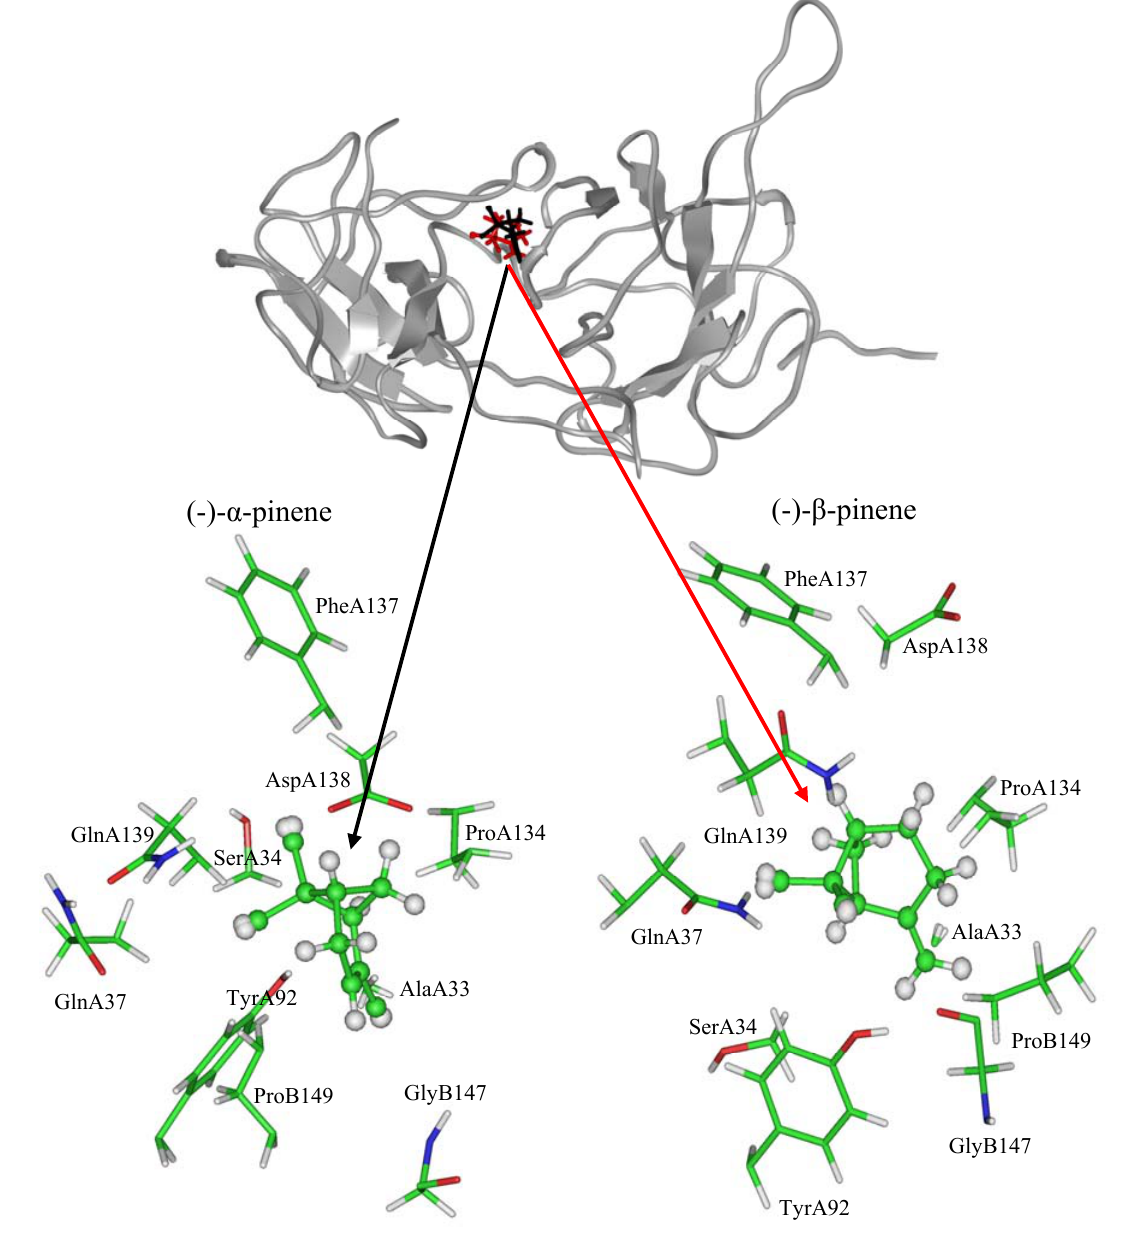
Figure 4. The modeled structures of (-)- α -pinene (black) and (-)- β -pinene (red) bound to the nucleocapsid (N)